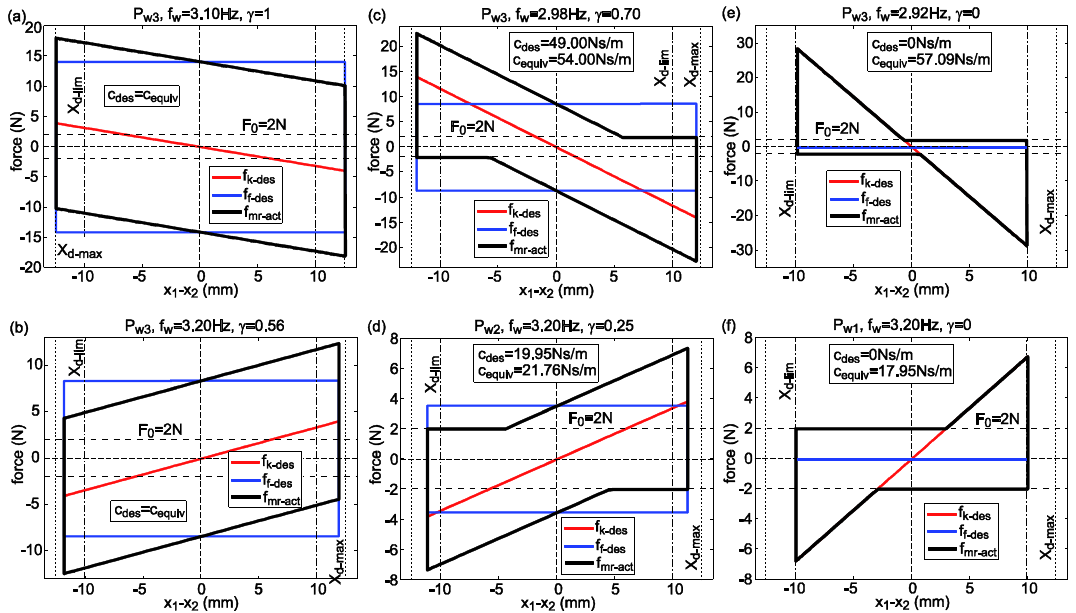
Figure 6. Simulated desired semi-active control force and resulting simulated actual MR damper force that is ( a , b ) not constrained by clipping and F 0 due to small differences between f w and f 1 , ( c – f ) constrained by clipping and F 0 due to larger differences between f w and f 1 and ( c , d ) non-zero desired damping and ( e , f ) zero desired damping generating resetting stiffness.